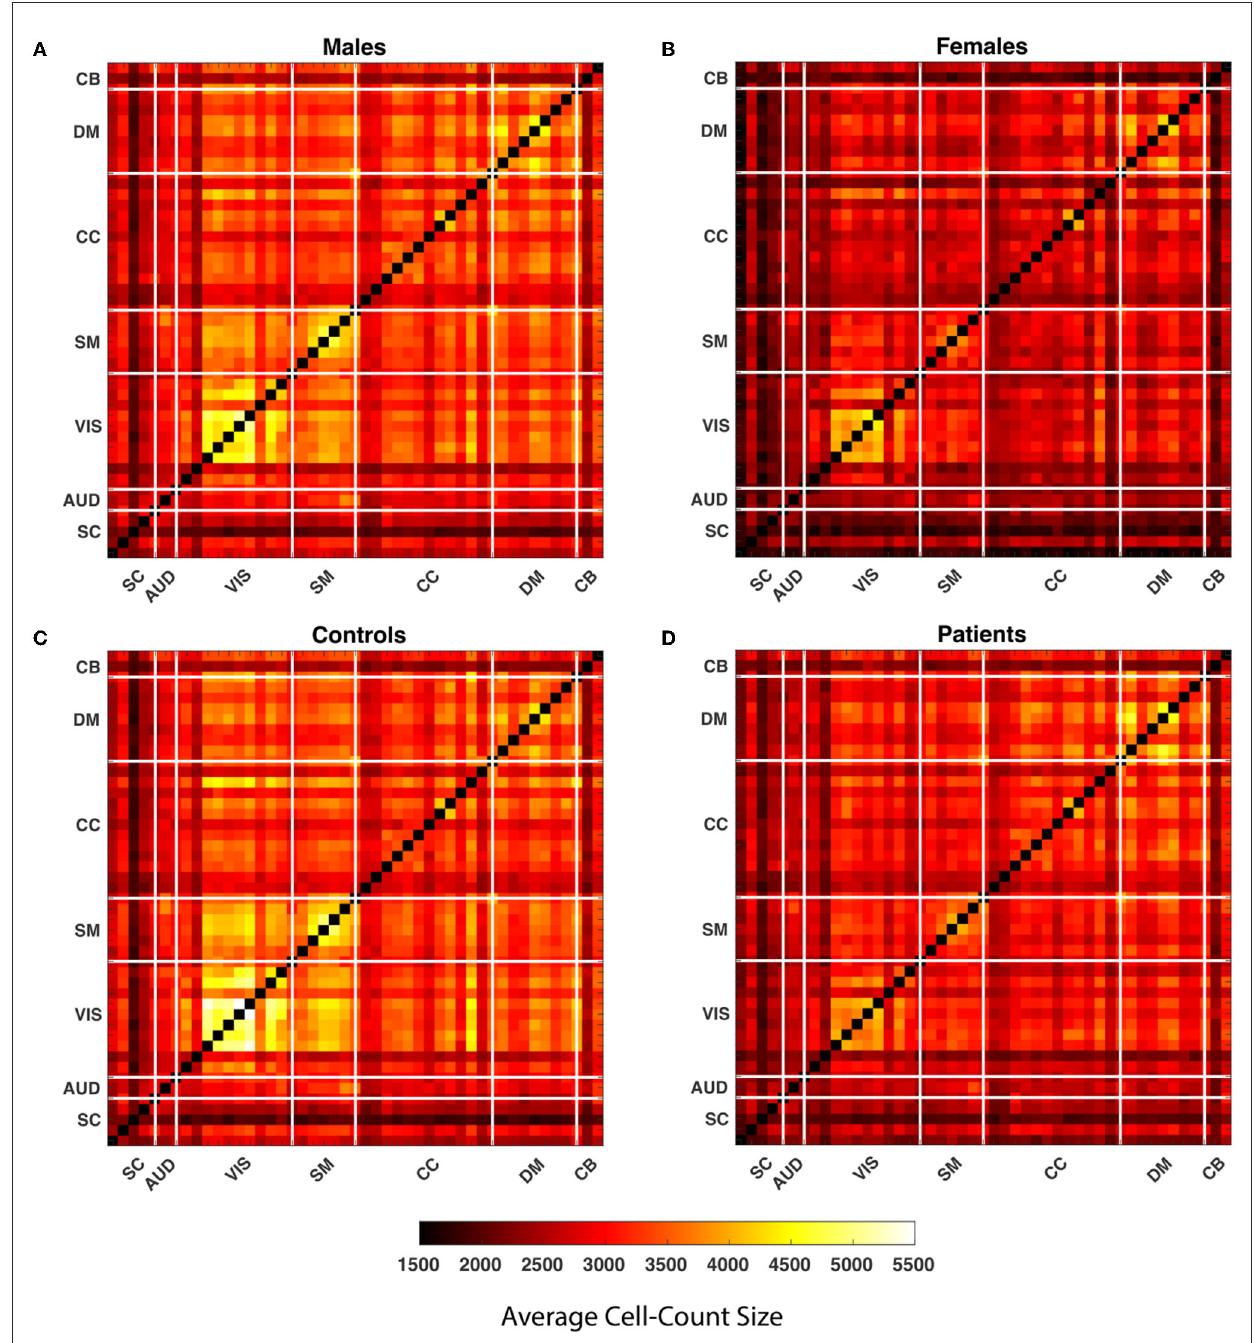
FIGURE6 The average cell count is calculated throughout all WW correlation maps for each quartile within the subgroups. In the figure, each cell of the matrices represents the average cell count of a particular component pair for the subgroups. The matrices represent the average cell count of the male, female, healthy controls and people with schizophrenia in quartile four from (A–D) . The thick white lines split the map into regions for seven distinct networks defined in the methods